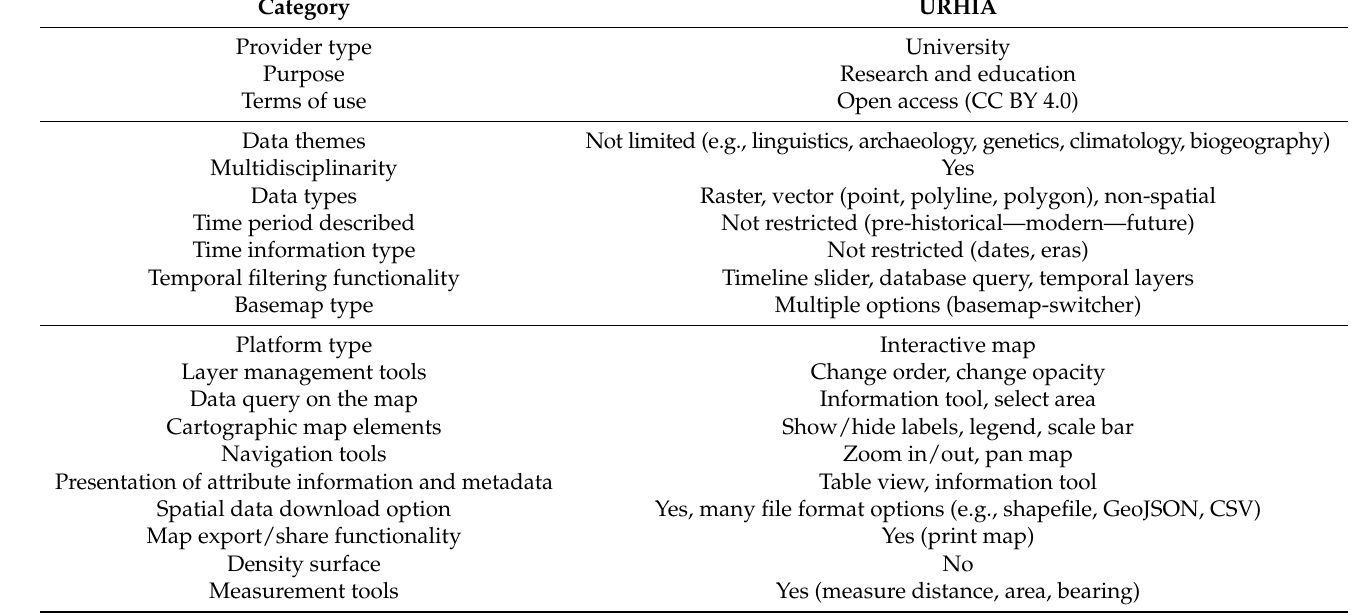
Table view, information